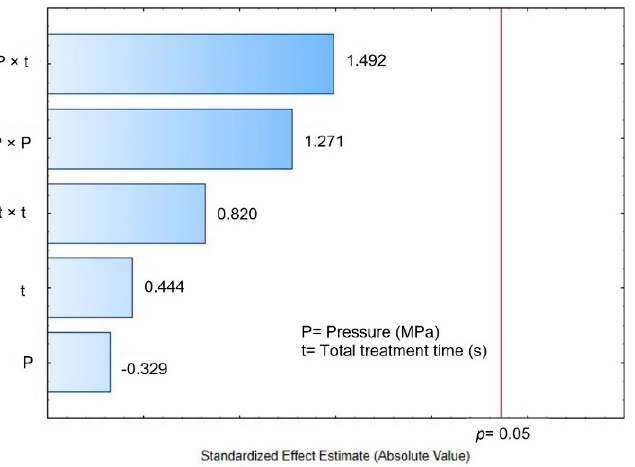
Figure 2. Pareto chart: effects of steam pressure (MPa) and treatment time (s) of DIC treatment on the thousand kernel weight (g) of maize kernels. Table 2. Effect of DIC treatment on the thousand kernel weight and apparent drying coefficient of maize kernels.